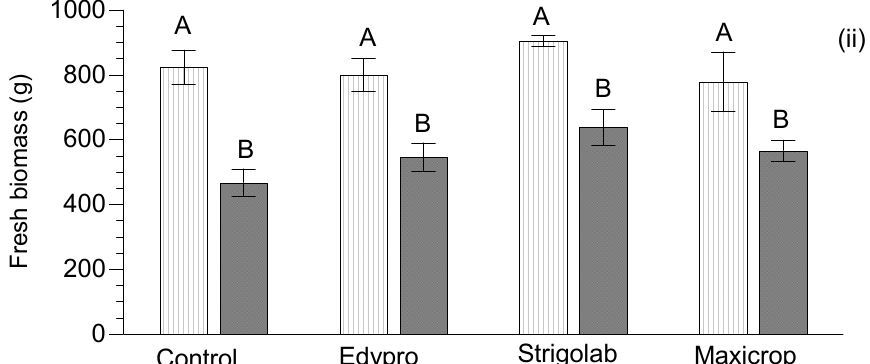
Figure 4. Effects of combined water and nutrient stress and biostimulant application (Control: No biostimulant applied, Edypro: application of COUPÉ REGENERACIÓN and PROCUAJE RADICULAR, strigolactone-based biostimulant, and Maxicrop) on tomato aboveground biomass (g) ( i ) 70 days after transplanting, and ( ii ) at the end of the cultivation period. Means ( n = 4) followed by different letters indicate significant differences according to Duncan’s multiple range test ( p < 0.05).